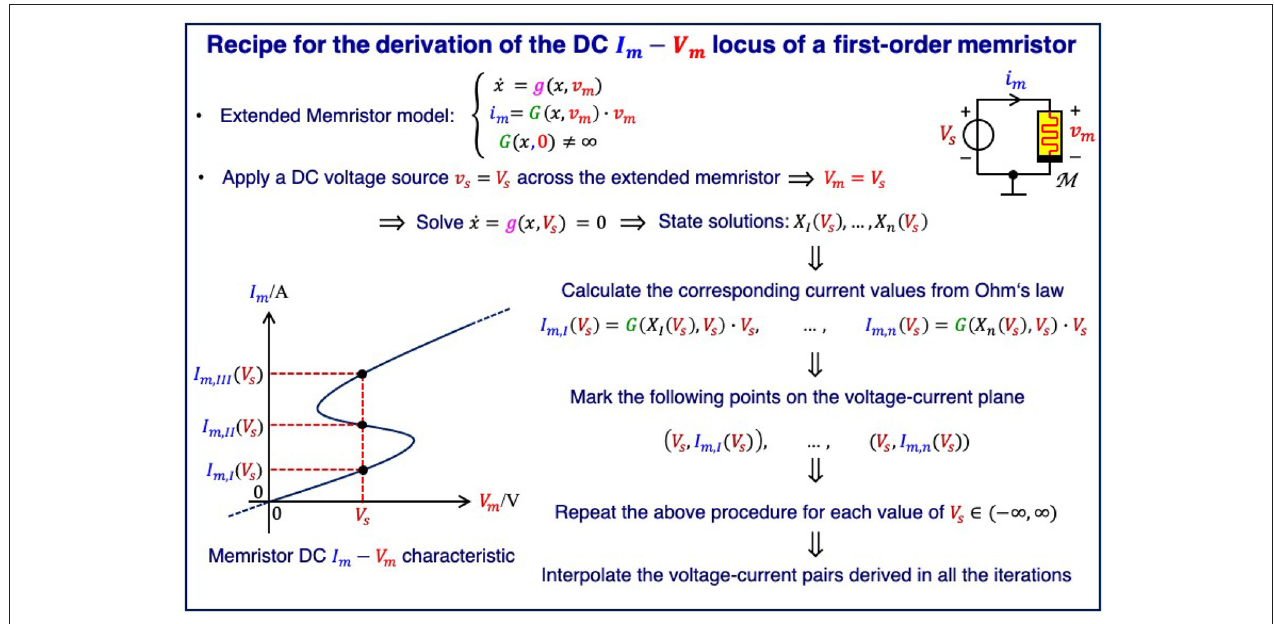
FIGURE 1 | Rigorous method for the determination of the DC current-voltage locus of a first-order voltage-controlled extended memristor.